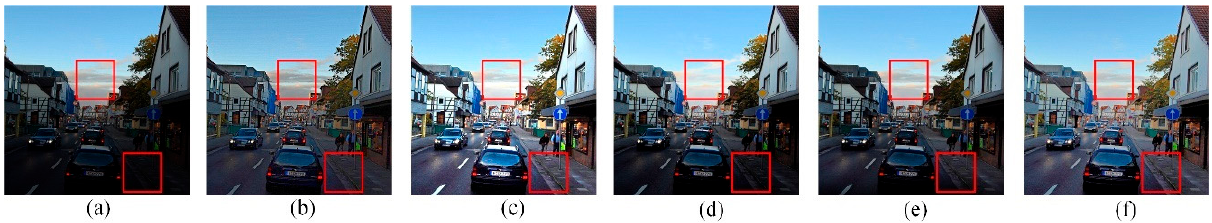
Figure 19. Baby image. ( a ) Original image; ( b ) result of Lee’s method; ( c ) result of LIME; ( d ) result of AGCWD; ( e ) result of SIRE; ( f ) result of the proposed method.